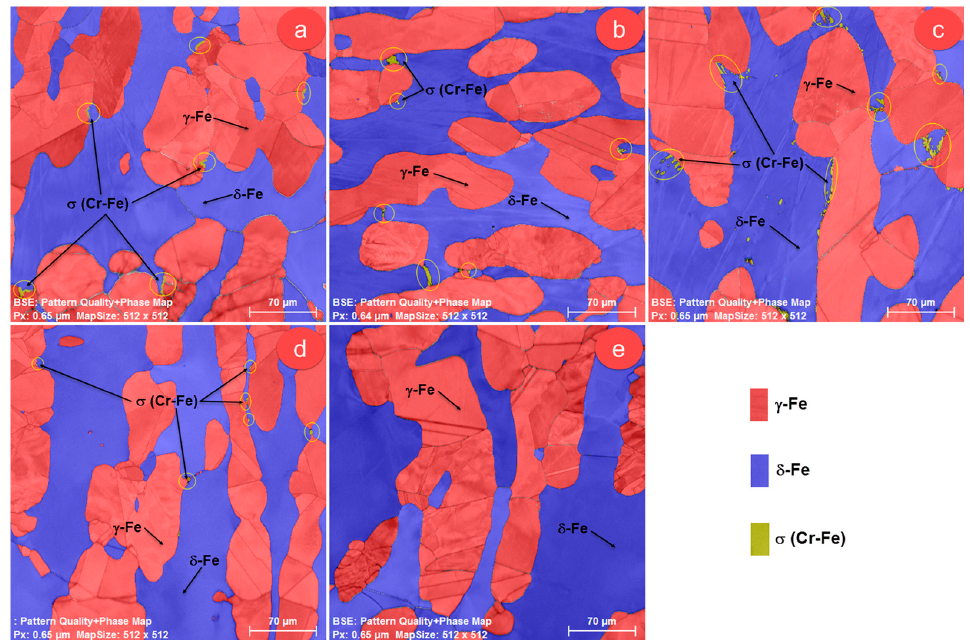
Figure 3. SEM-EBSD Pattern Quality (PQ) and composite phase distribution map of: ( a ) as-forged UNS S32750/1.4410/F53 SDSS alloy; ( b ) solution-treated (ST) at 800 °C for 0.6 ks; ( c ) ST at 900 °C for 0.6 ks; ( d ) ST at 1000 °C for 0.6 ks; ( e ) ST at 1100 °C for 0.6 ks.